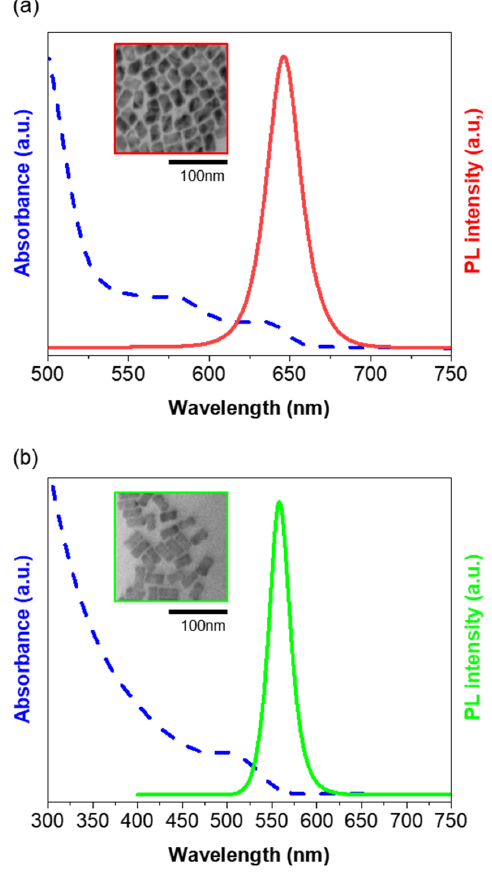
Figure 2. Typical SEM image and absorption/emission spectra of ( a ) the colloidal core/shell red-emitting quantum nanoplatelets (peak emission = 646 nm, FWHM = 25 nm, and PLQY (460 nm) ~ 88%) and ( b ) the green-emitting quantum nanoplatelets (peak emission = 558 nm, FWHM = 30 nm, and PLQY (460 nm) ~ 80%).